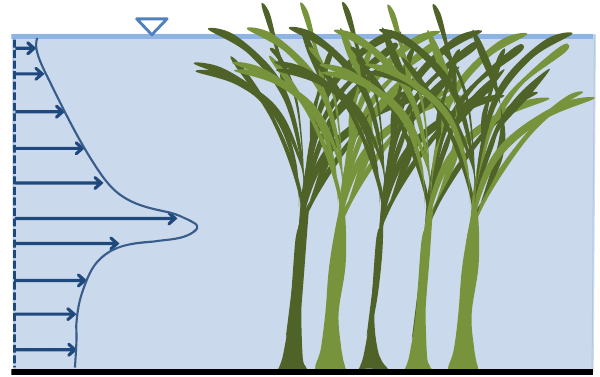
Fig. 8. Schematic of the flow field for emergent aquatic vegetation. (Figure adapted from Nepf,